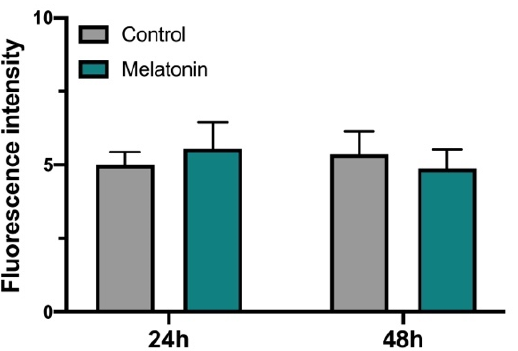
Figure 2. ROS/RNS levels in hGL cells treated with melatonin. Histogram representing total OS measures ( n = 3) in hGL cells after 24 and 48 h of melatonin exposure compared to control.